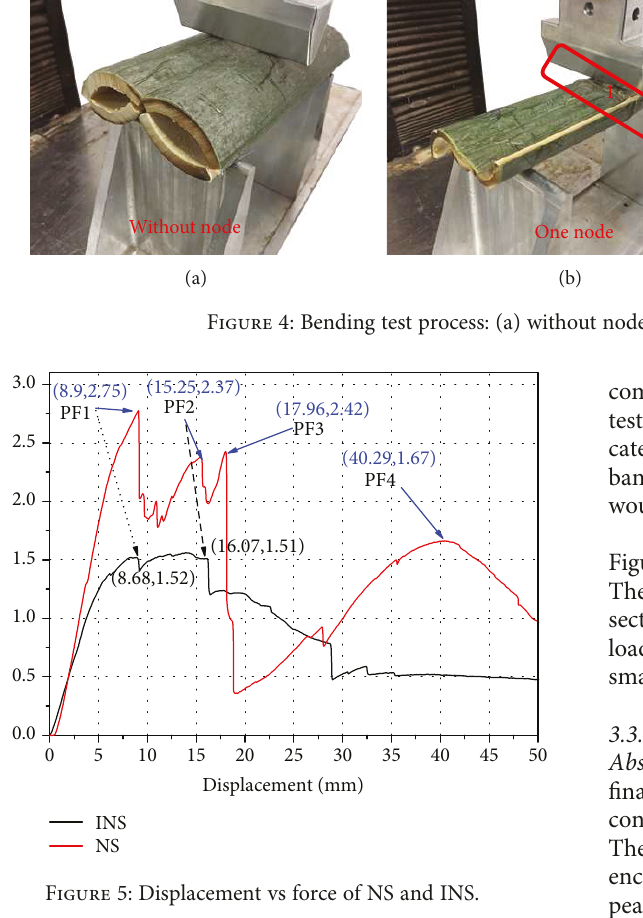
Figure 5: Displacement vs force of NS and